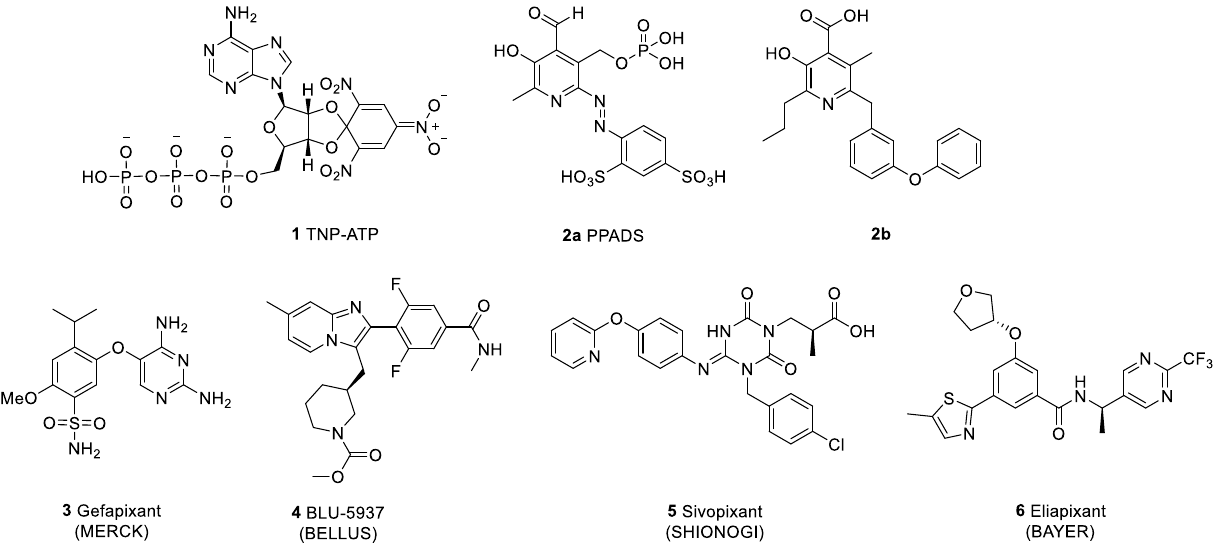
Figure 1. Structures of various hP2X3 receptor antagonists.